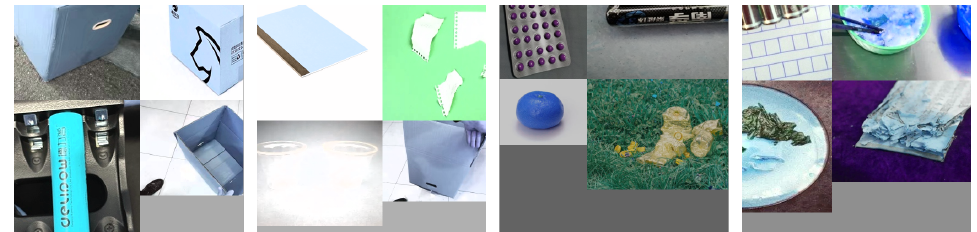
Figure 2. Improved data augmentation method for the garbage data